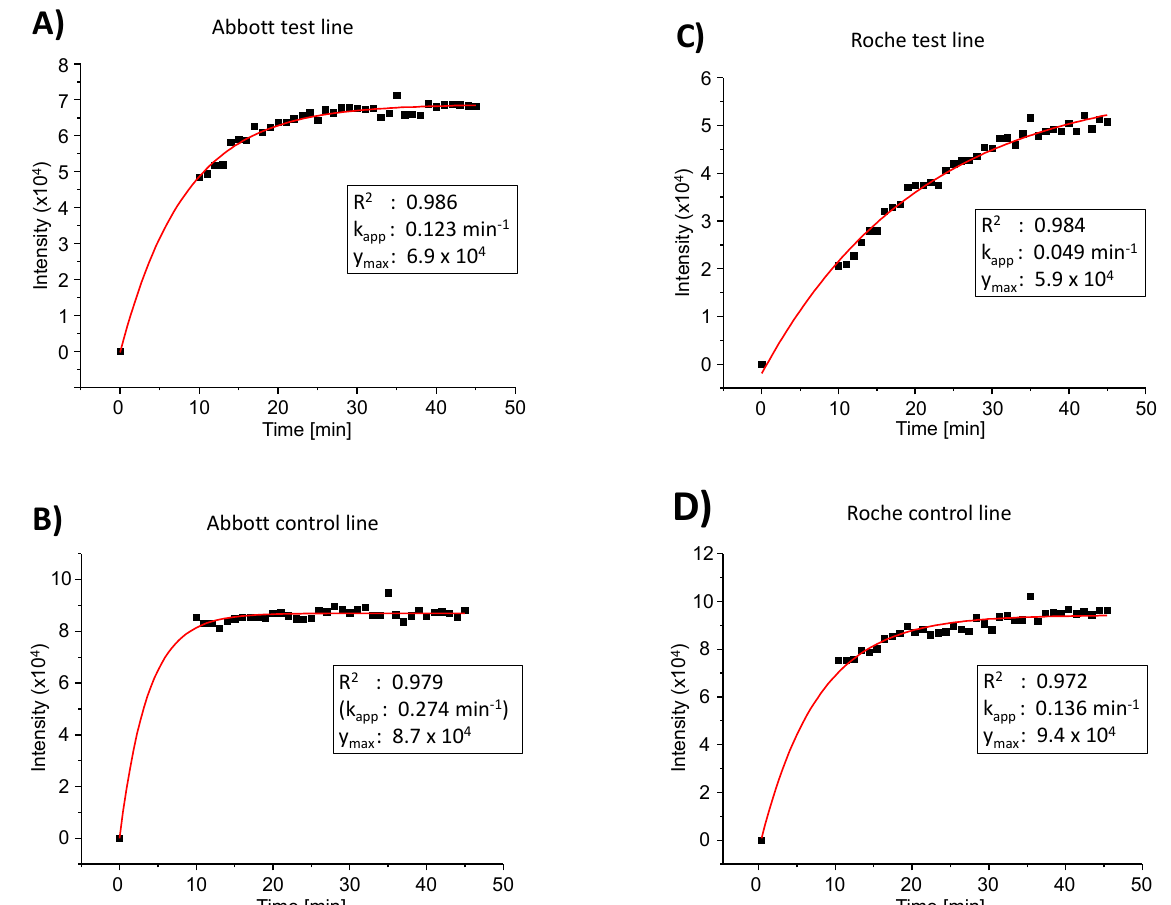
Figure 5. Kinetics of binding of colloids at the test and control lines of the PanBio test from Abbott, or the Rapid Antigen test from Roche Diagnostics, as determined by image analysis of photographs taken at stated intervals after applying the antigen-containing extract of the Abbott test to the test cassettes. Five specimens of healthy and negatively tested volunteers among the authors and one positive control swab (Abbott) were extracted with the buffer of the Abbott test in the device of Figures 1–3. The extracts were then applied to each of the test cassettes. Data collection started 10 min after the extracts were applied. Black boxes are experimental data points and red lines are fit to an exponential kinetic model using the fit equation y = y max · (1 − exp(k app · t)), where y are the intensity values, t is the time of data acquisition, y max is calculated maximum intensity at infinite time, and k app is the apparent rate constant for the process. Boxes below each plot give the numerical values obtained. The apparent rate constant for the Abbott control line is not defined by a sufficient number of early data points and is therefore reported in parentheses. ( A ) Abbott test line, ( B ) Abbott control line, ( C ) Roche test line, and ( D ) Roche control line. Note the different scales of the y-axes for the different plots.